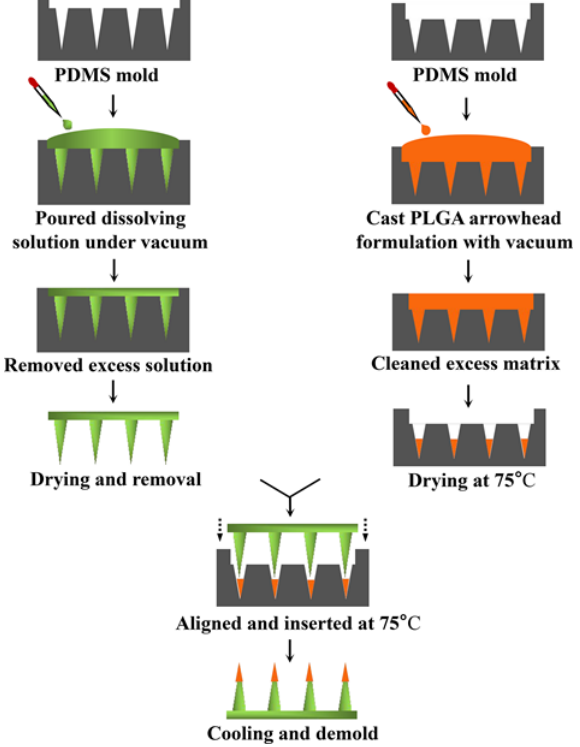
Figure 2. Schematic of IPMNs fabrication process.